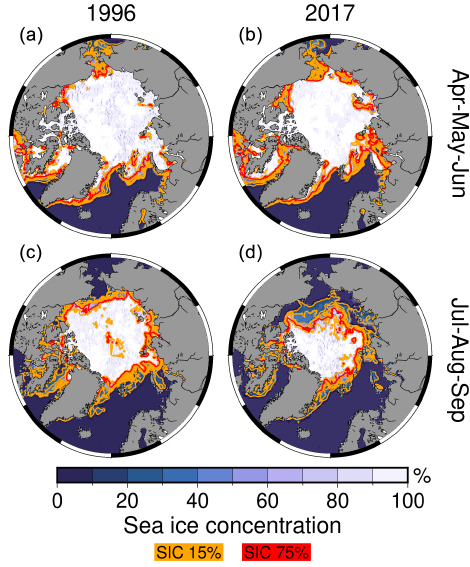
Figure 5. Sea ice concentration (SIC) for Arctic spring (a, b) and Arctic summer (c, d) for 1996 and 2017. Data from Walsh et al. (2019). The orange and red contours indicate SIC of 15% and 75%.